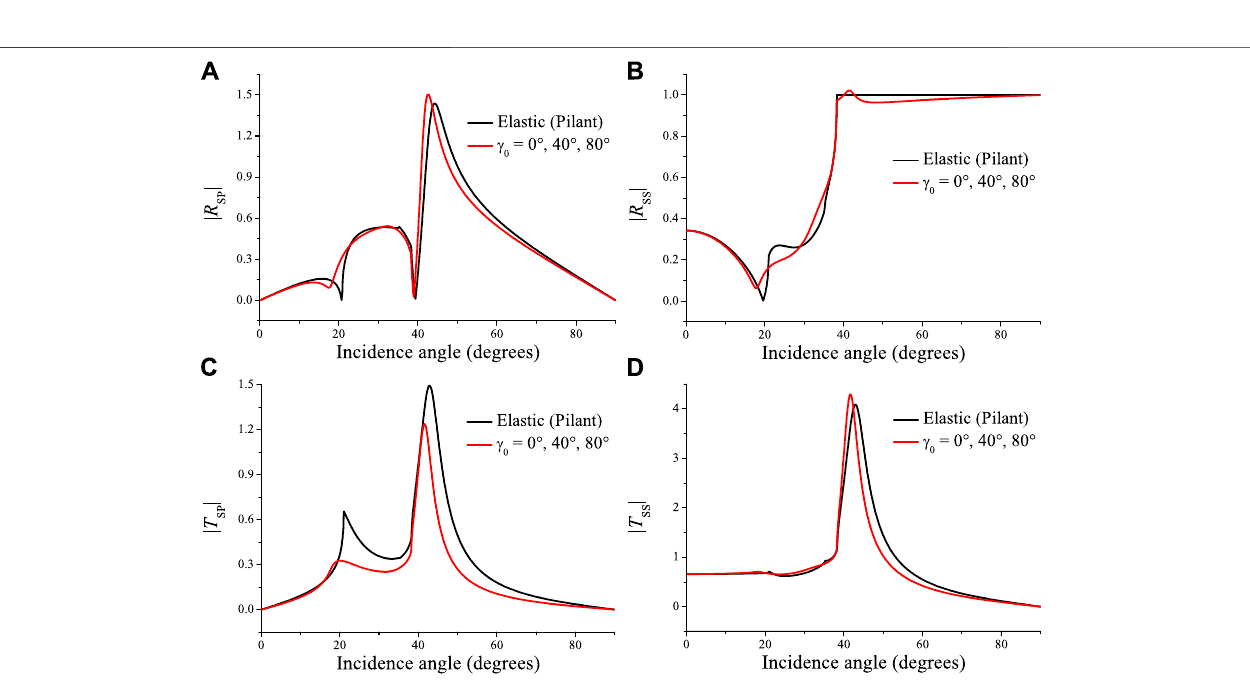
Frontiers in Earth Science |